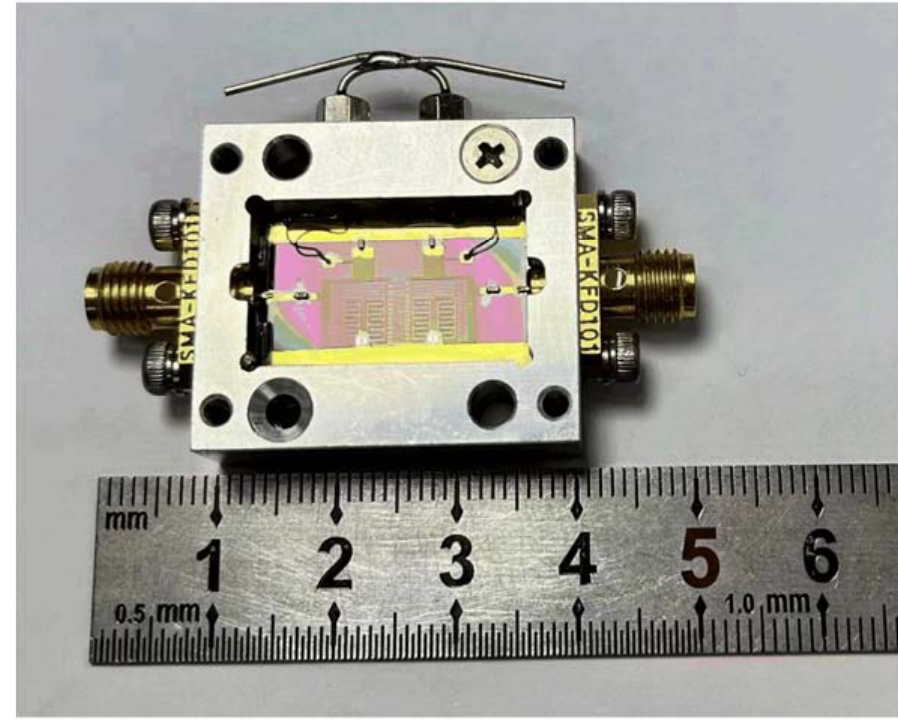
Figure 8. Image of the as-fabricated HTS bandpass filter with connectors. The filter was cooled to 77 K. The results of the experimental measurements are shown in Figure 9. The experimental measurement results in cases of different BVs are listed in Table 2. The filter frequency can be tuned in the range of 1.22~1.34 GHz. The passband maximum insertion loss was approximately 3.59 dB at 3 V. However, the insertion loss at the lower side was higher than that at the upper side. This can be attributed to the DC blocking capacitors, which influenced the even mode (but not the odd mode) at lower frequencies, as shown in Figures 2 and 3. The measured bandwidth is a little wider than the simulated one. This may be caused by DC block capacitors, fixed capacitors, and varactors. The decrease of in-band return loss leads to enlarged bandwidth. Despite the bias state, the return loss of the passband exceeded − 8 dB in most cases. As presented, the 3 dB fractional bandwidth increased with increasing bias. As BV increased from 3 to 13 V, the 3 dB fractional bandwidth increased from 12.95 to 17.39%. The proposed filter was compared with several varactor-tunable microstrip filters in terms of performance, as shown in Table 3. The proposed filter exhibited a relatively small insertion loss and larger fractional bandwidth than